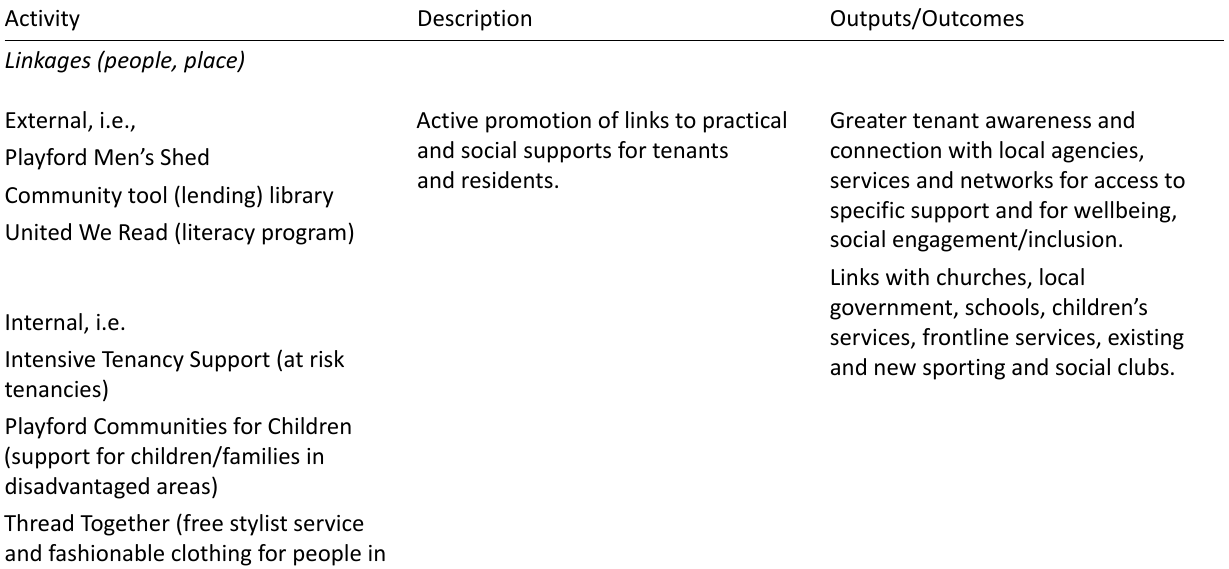
Table 1. (Cont.) Community development activities, northern Adelaide Better Places, Stronger Communities